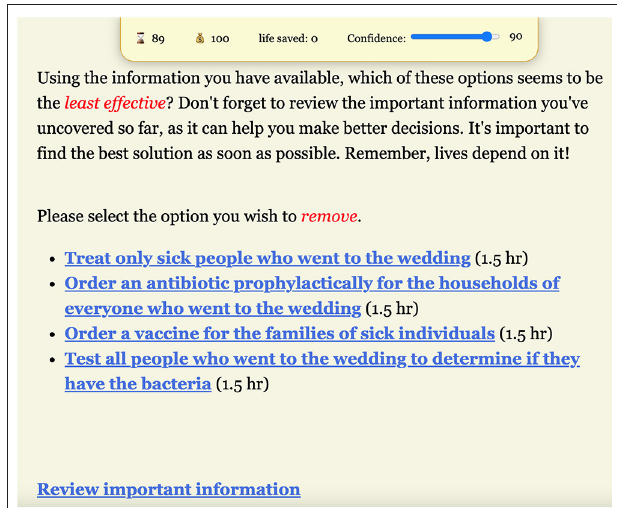
FIGURE 2 | Screenshot of a decision point in the prototype. Players are presented with a short quantitative research finding and then asked to initiate a decision about intervention through a process of elimination. Focus group participants identified such processes as unnecessarily indirect and time-consuming. Our next steps will reduce the number of decision points, such that players will see all research findings at once and proceed to select the most evidence-supported